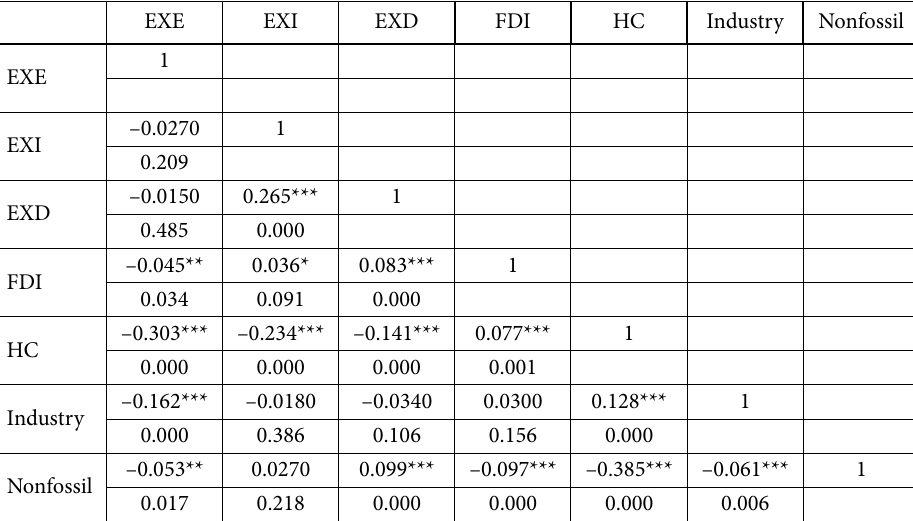
Table 1. Correlation matrix among the variables EXE EXI EXD FDI HC Industry